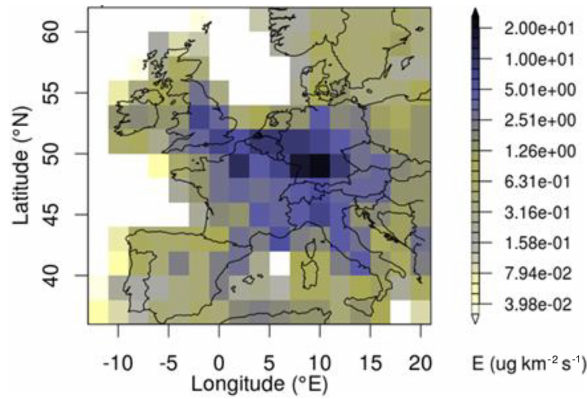
Figure 7. Top-down inversion emission estimate for western Europe (2013–2018). Average of InTEM (seven observation sites), EBRIS (four observation sites), and FLITS (four observation